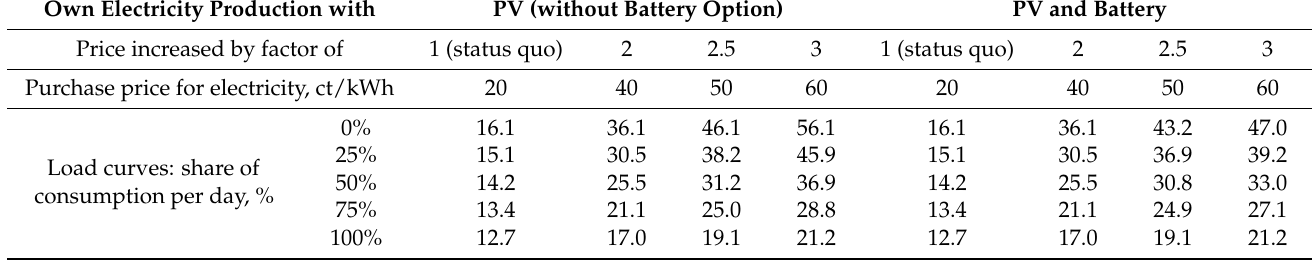
Table 7. Costs of farm’s power supply.